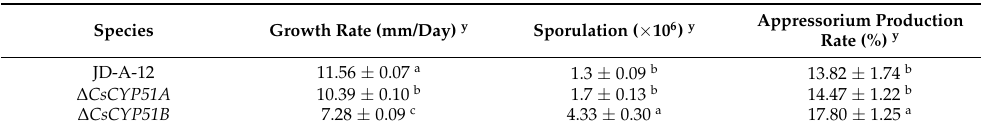
Figure 4. Colony morphology of wild-type JD-A-12 and CsCYP51A and CsCYP51B deletion mutants from the top of the PDA plate (a1 – c1, from the underside of the PDA plate (a2 – c2), conidia (a3 – c3) and appressoria (a4 – c4), scale bar: (a3 – c3, a4 – b4) = 20 µm. Table 3. The growth rate, sporulation, and appressorium production rate of wild-type JD-A-12 and CsCYP51A and CsCYP51B deletion